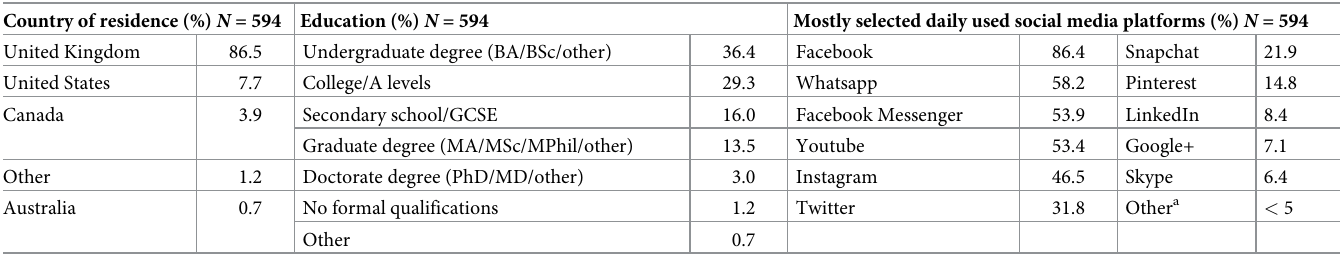
Table 2. Descriptive statistics of participants. Country of residence (%) N = 594 Education (%) N =